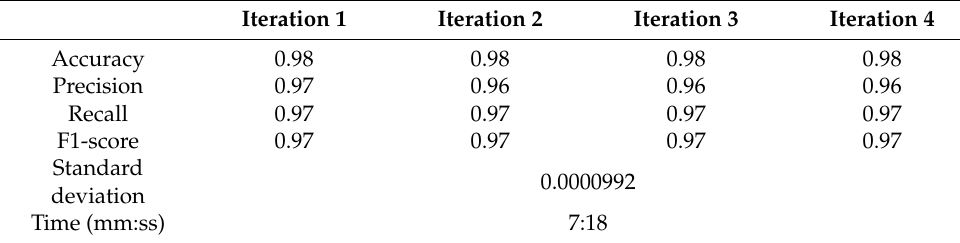
Table 2. Parameters obtained during the CV